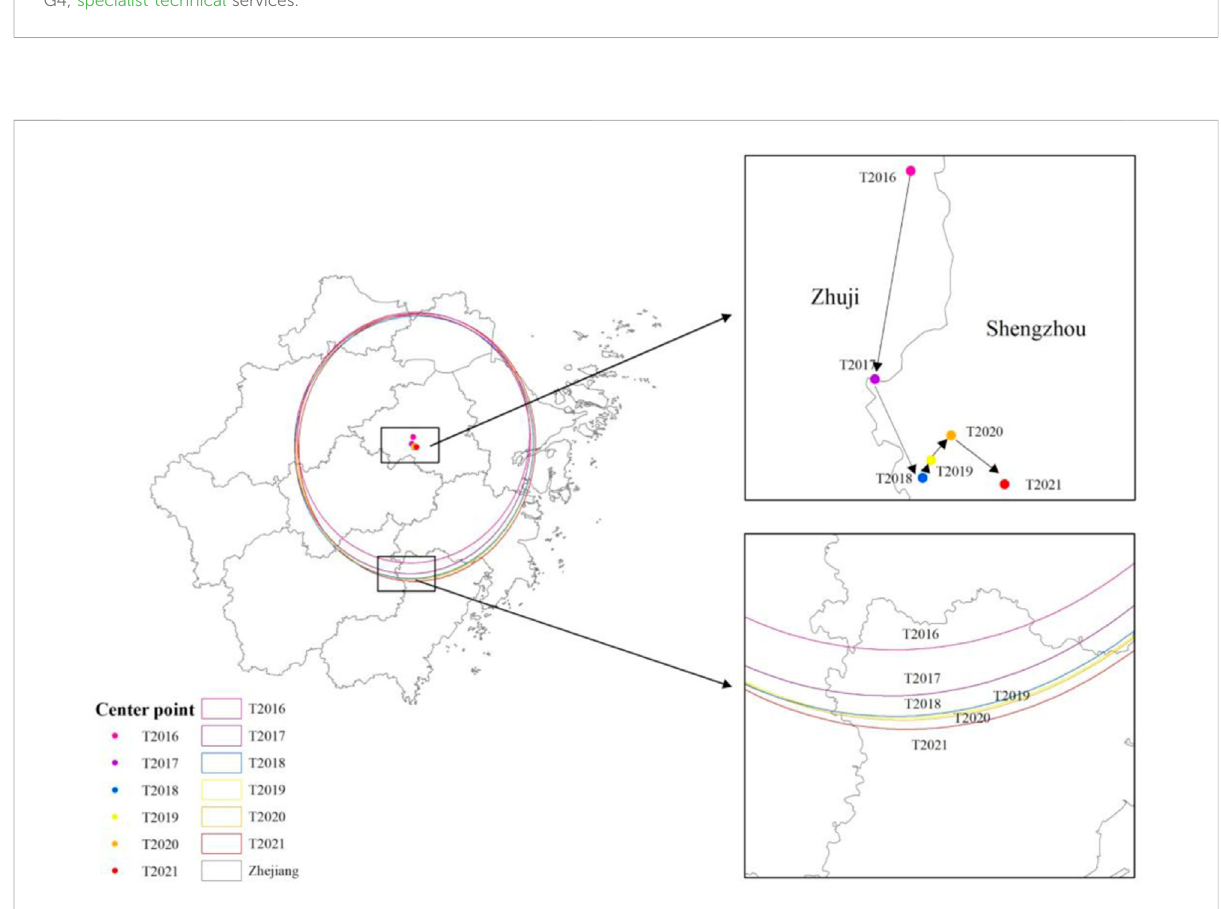
FIGURE 2 Ellipse of standard deviation of Zhejiang new energy